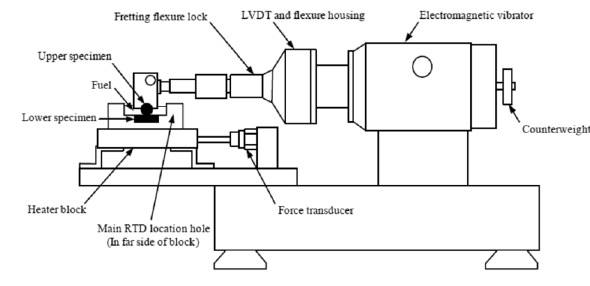
Fig. 1. Schematic Diagram of HFRR [18]